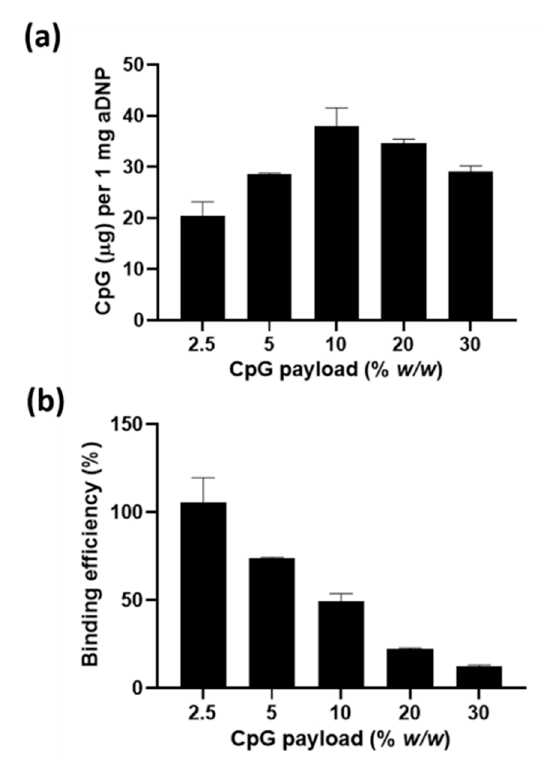
Figure 6. ( a ) Amount of CpG (µg) bound onto 1 mg of amino-dextran nanoparticles (dry weight equivalent) ( b ) CpG binding efficiency after loading different payloads of CpG on